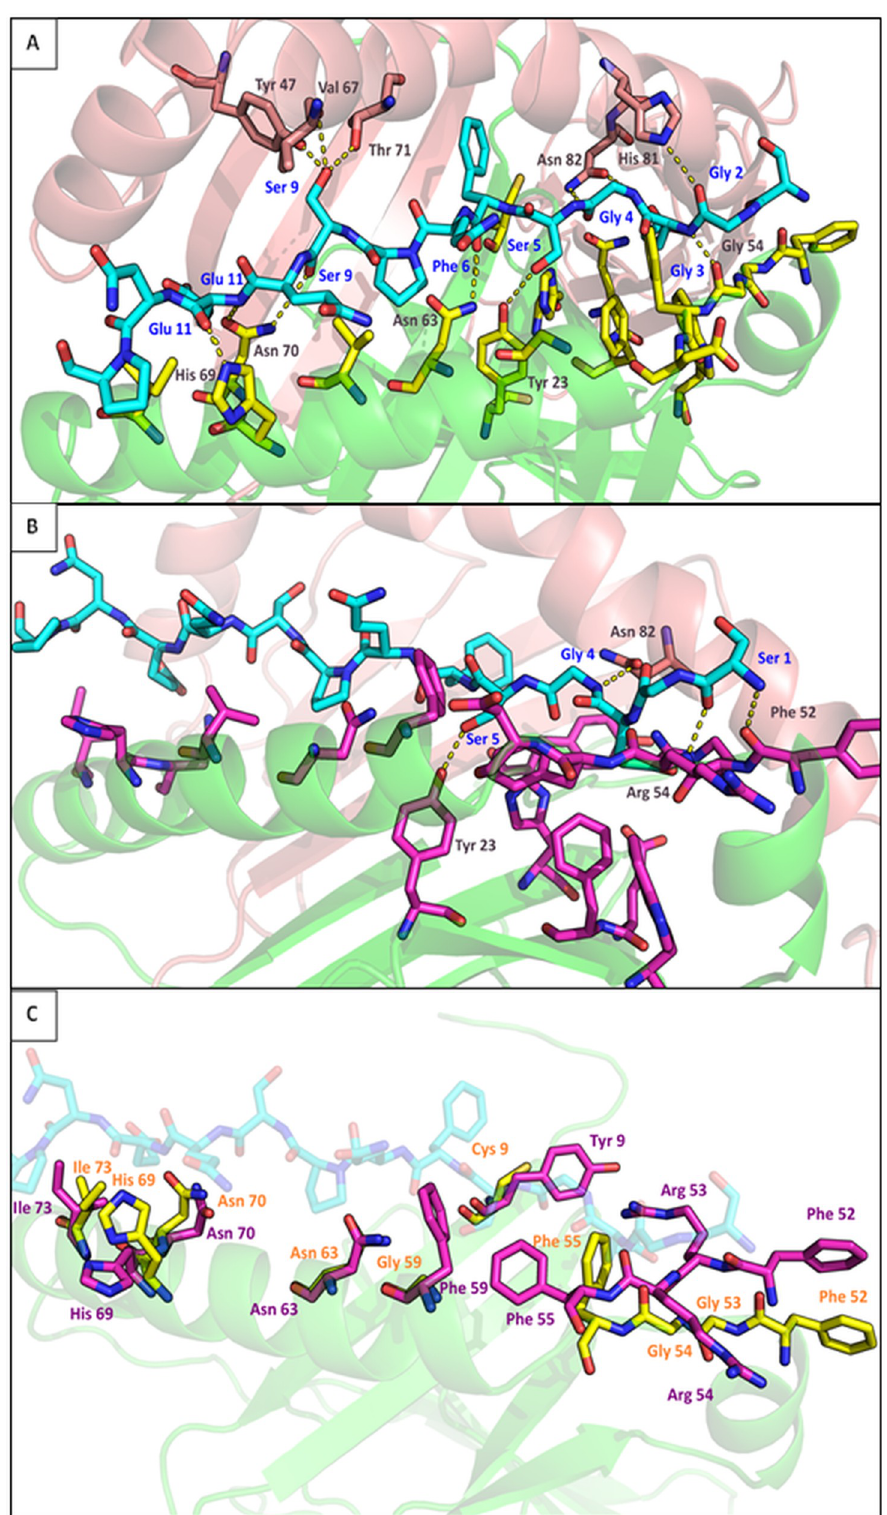
Fig 4. Graphical representation of DQA1/DQB1 molecules. α chain is shown in red and β chain in green. In the center of the groove, the peptide (chain C from PDB ID: 2NNA) is shown in cyan sticks. The residues of the